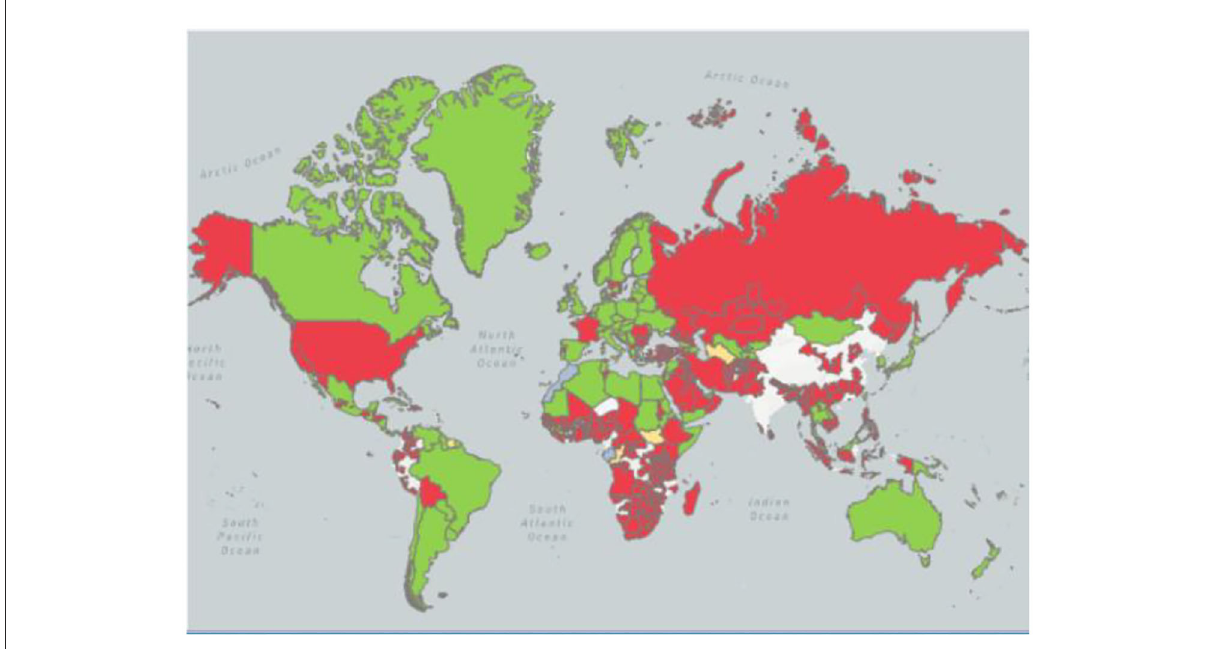
FIGURE1 The prevalence of OIE in NDV in the past 5